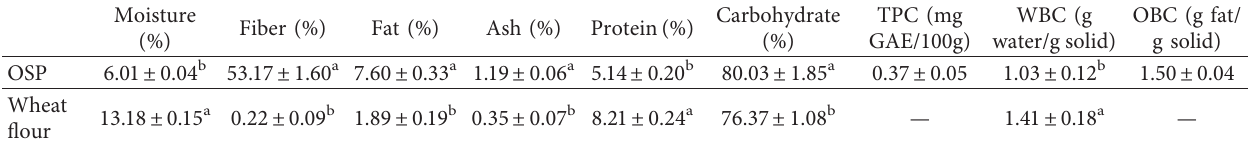
Table 1: Physicochemical properties of OSP and wheat flour †